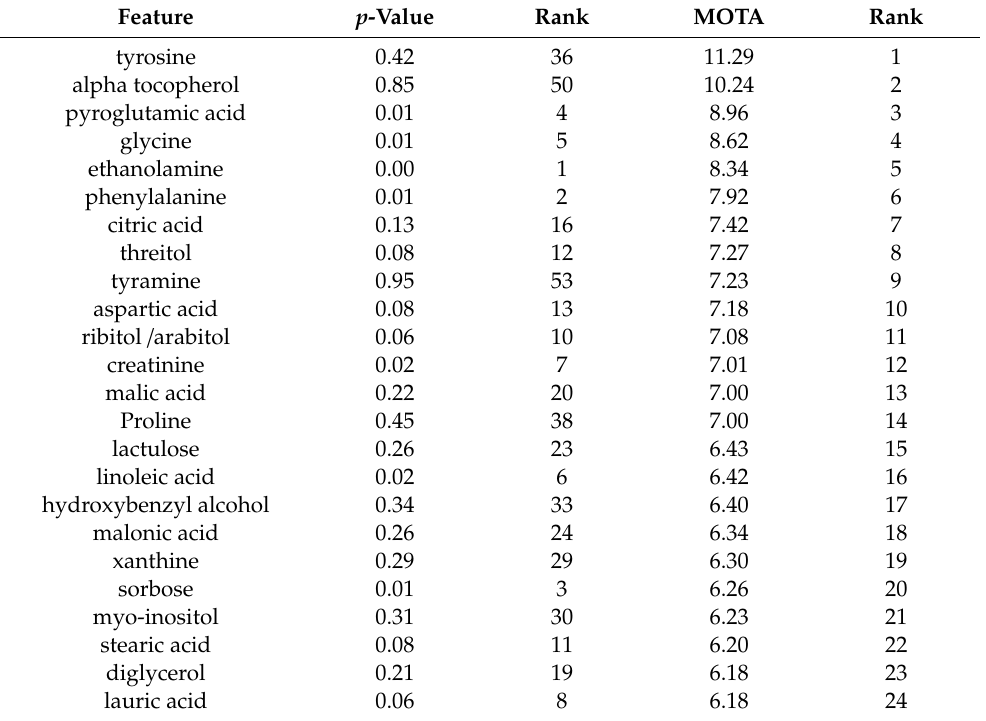
Figure 2. Network constructed by MOTA using the GU1 dataset, which consists of metabolomic, proteomic, and glycomic data, to rank metabolites. The size of a metabolite node is proportional to the corresponding MOTA activity score. Table 2. Ranking of metabolites in TU datasets. The p -value is calculated using Student’s t -test.